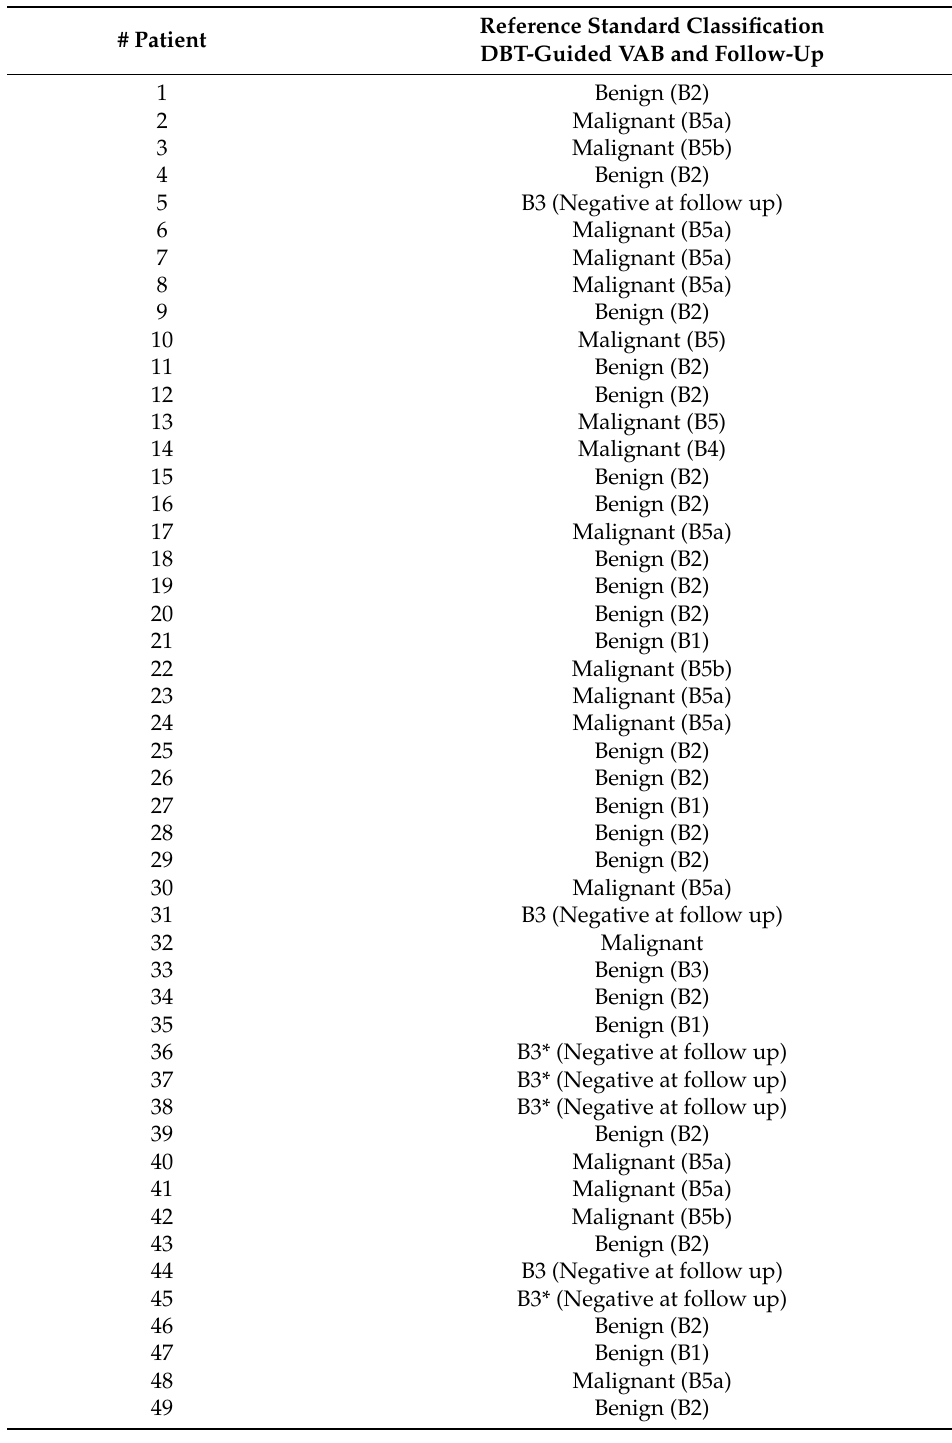
Table 1. Reference standard classification (from DBT-guided VAB and follow-up) for each patient included in the